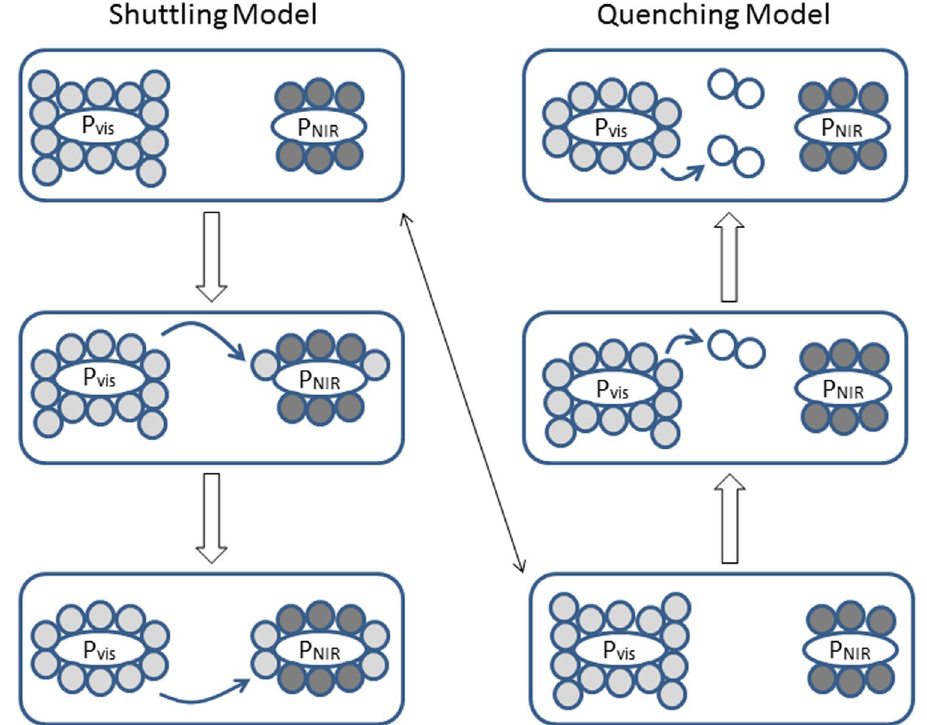
Figure 3. State transitions in hypothetical photosynthesis using NIR radiation in shallow water. Ovals show the reaction centers excited by visible (P vis ) and NIR (P NIR ) radiation. Light gray circles show light-harvesting antenna absorbing visible radiation. Dark gray circles show light-harvesting antenna absorbing visible and NIR radiation. Shuttling model: When the cell descends in the water, a part of the visible-radiation-harvesting antenna moves from P vis to P NIR (shown in the left scheme). Quenching model: When the cell rises towards the surface, part of the visible-radiation-harvesting antenna detaches from P vis and transitions to a quenching state (shown as open circles at the upper